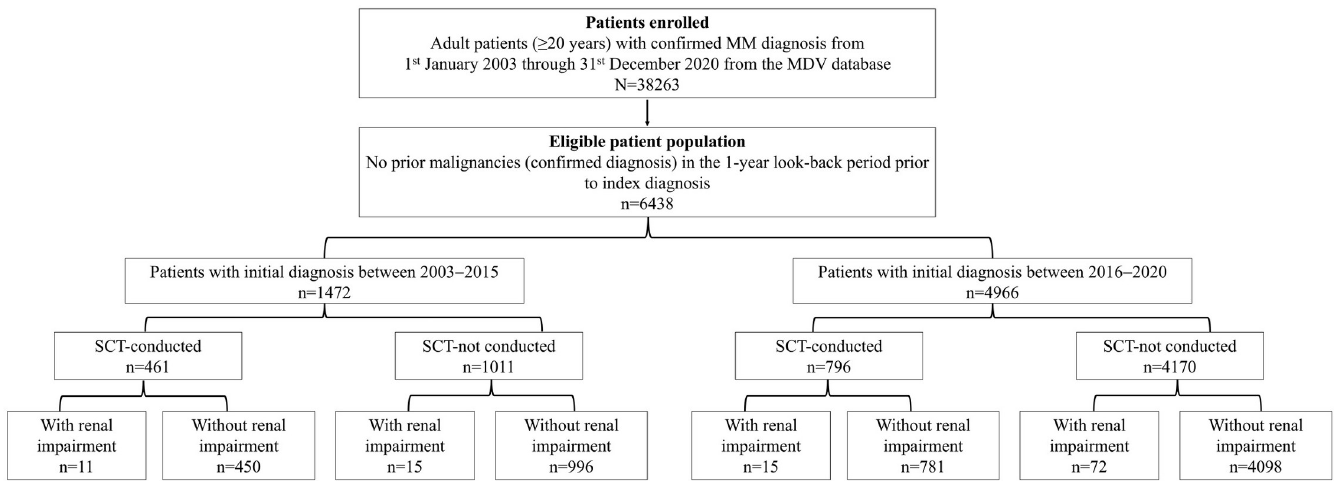
Fig 1. Study population flowchart. MDV, Medical Data Vision; SCT, stem cell transplantation. Note: ICD10 codes I12.0, I13.1, N03.2 -N03.7, N05.2 -N05.7, N18.x, N19.x, N25.0, Z49.0-Z49.2, Z94.0, and Z99.2 were selected to identify renal impairment.